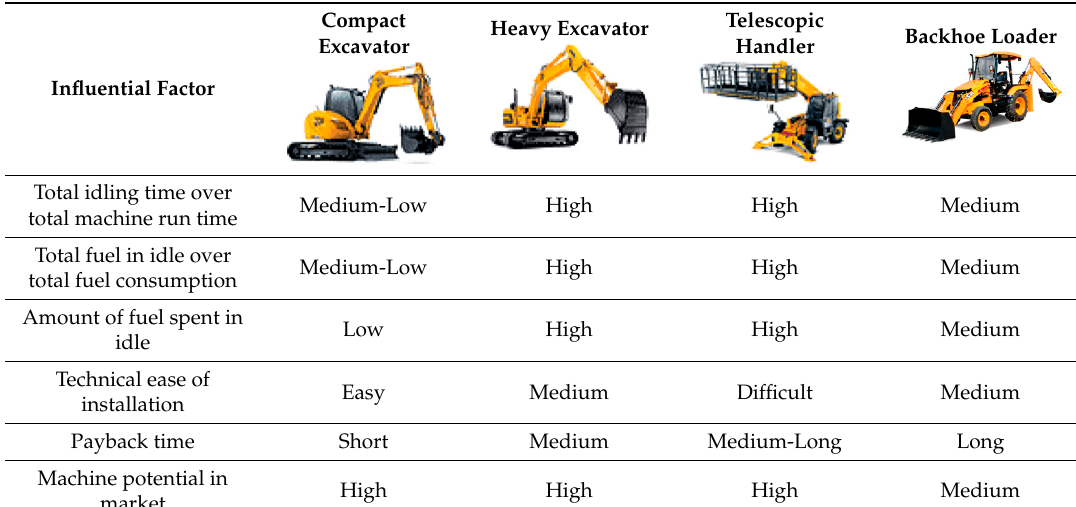
Table 2. Evaluation of factors having significant impacts on machine hybridization.